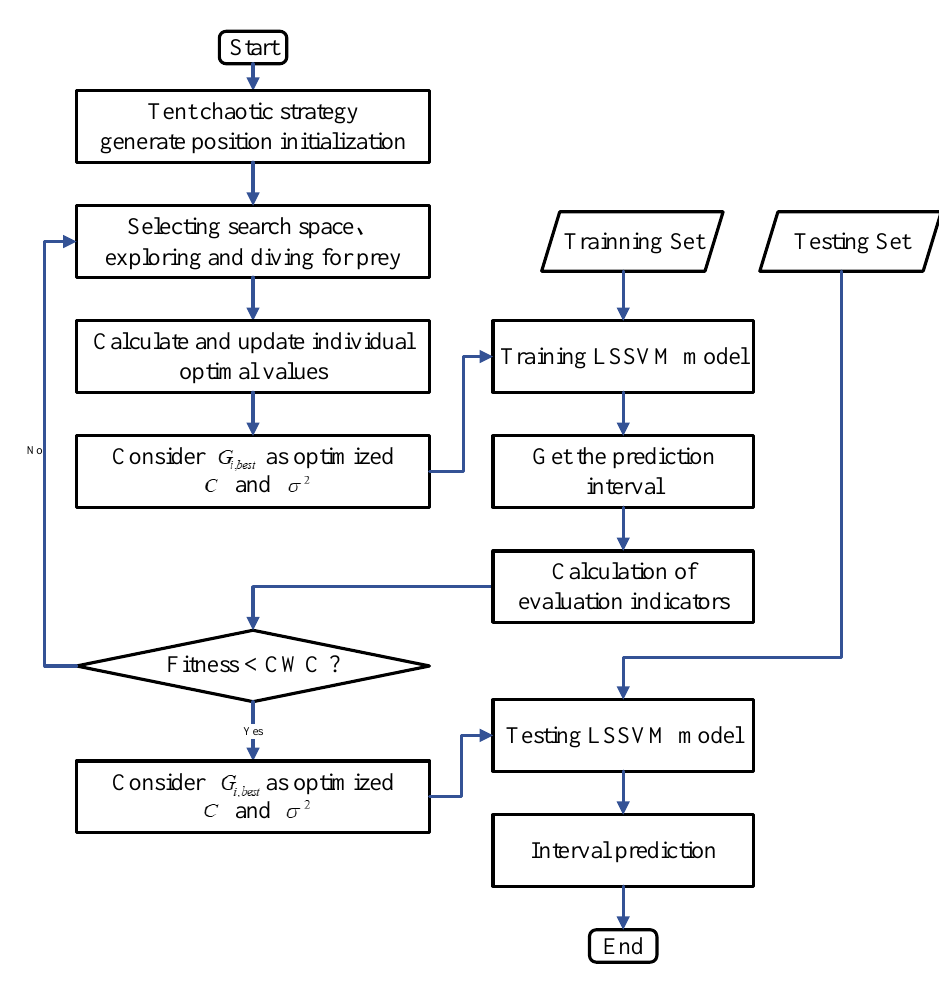
Figure 2. Flow chart of IBES-LSSVM